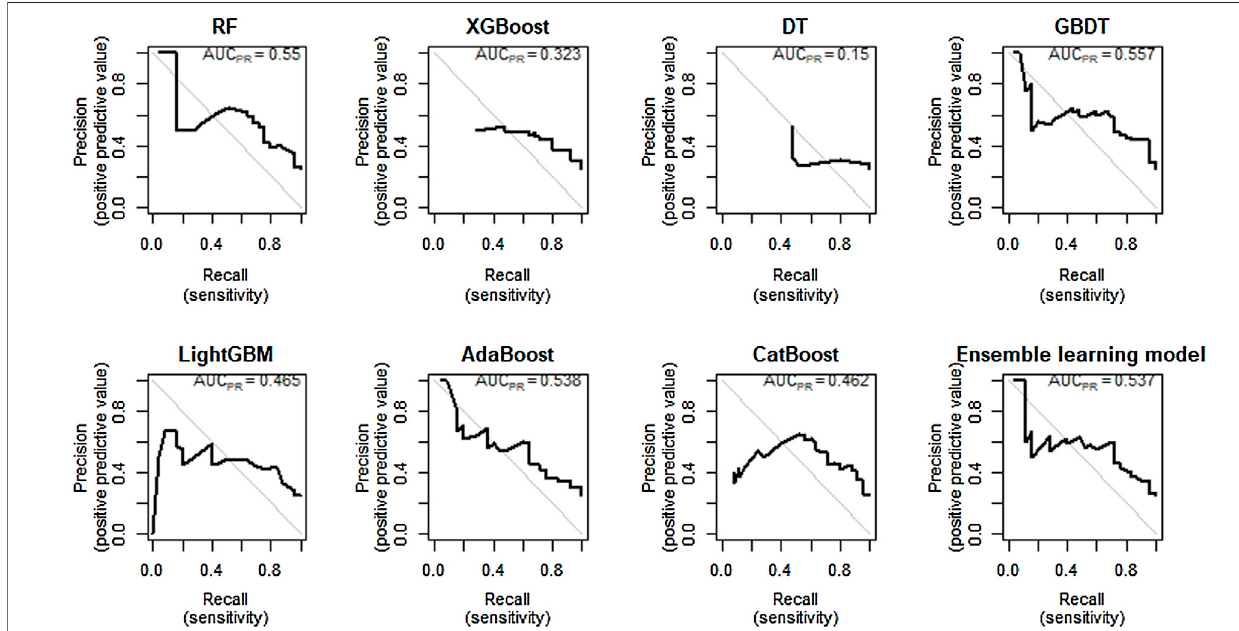
FIGURE 6 | PR curve of eight models in the test cohort.